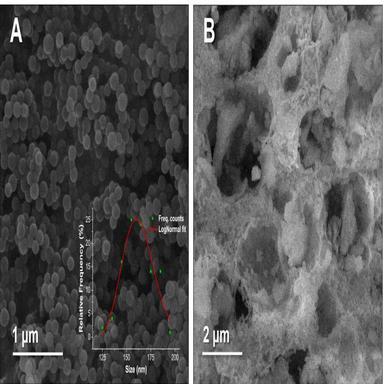
FE-SEM micrographs of A) Carbon hollow spheres and B) Sponge-like Eu2O3.